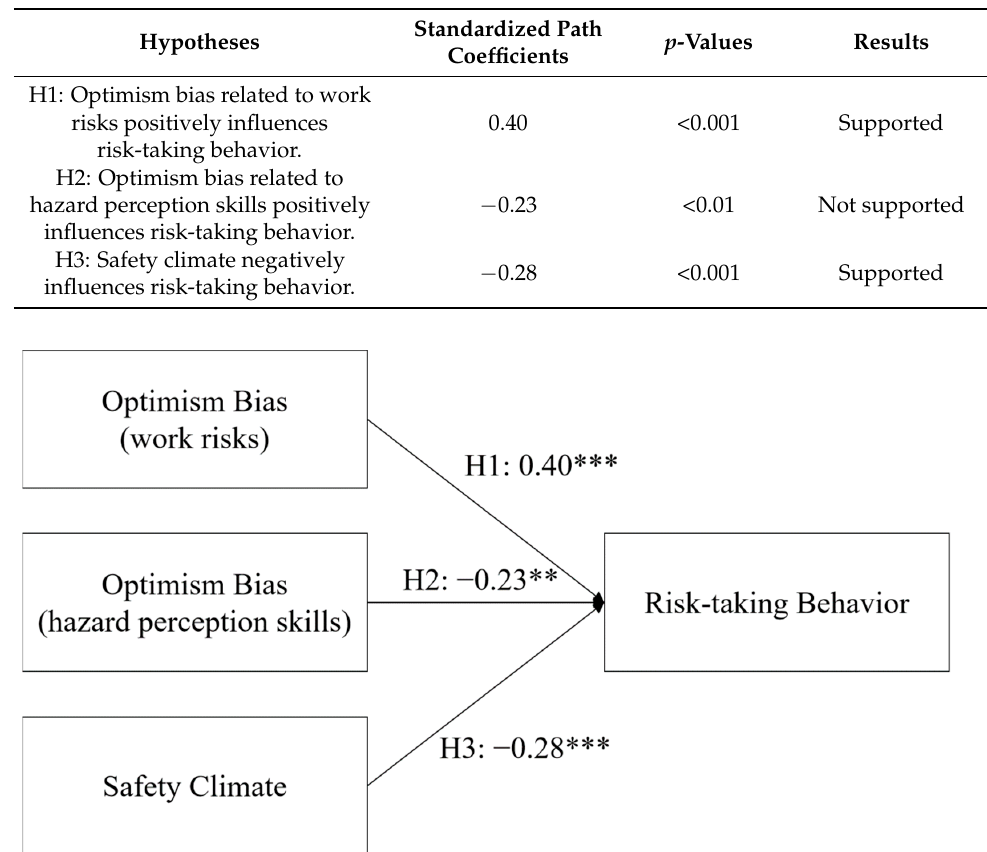
Figure 2. Proposed research model with hypothesis testing results (the values are standardized path coefficients; **: p < 0.01; and ***: p <